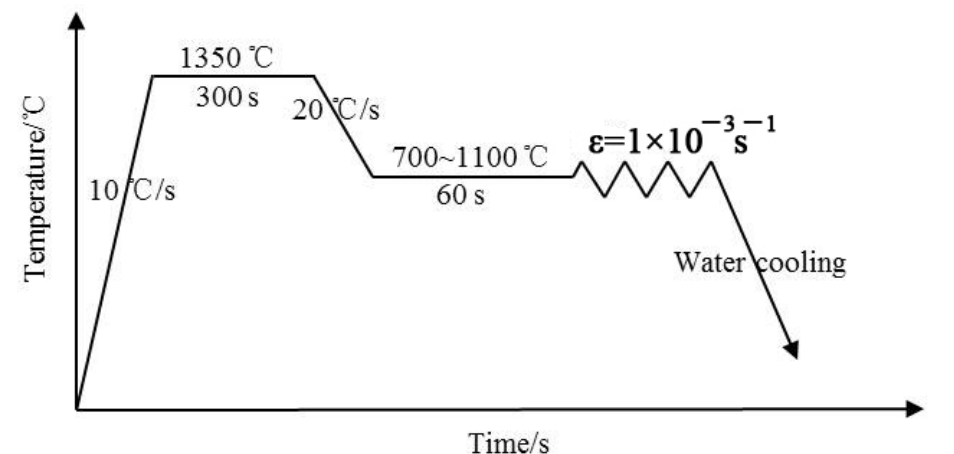
Figure 1. Thermal schedule of the hot tensile test.